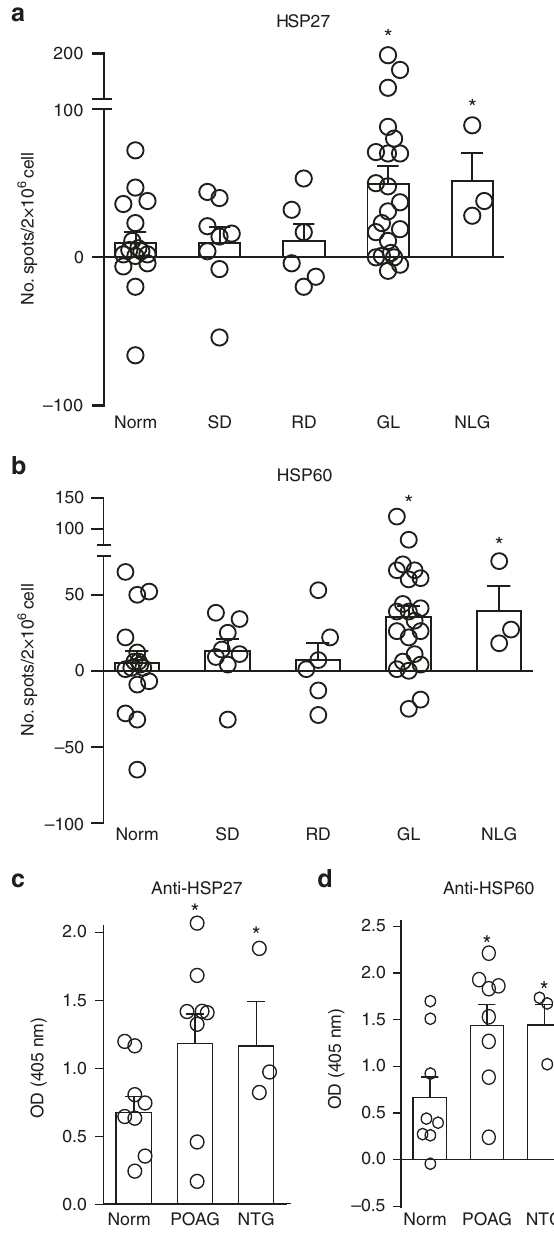
Fig. 6 T cells are involved in retinal neurodegeneration in human glaucoma patients. a , b Comparison of frequencies of HSP27- and HSP60-speci fi c T cells among healthy individuals and patients with POAG or other diseases. Peripheral blood mononuclear cells from patients with POAG ( n = 18), NTG ( n = 3), retinal detachment (RD; n = 6), skin injuries (SD; n = 8), and age- matched healthy controls (Norm; n = 16) were stimulated with HSP27 ( a ) or HSP60 ( b ). Two days later, the frequencies of IFN- γ -secreting cells were determined by ELISPOT. * P < 0.05 by ANOVA. c , d Comparison of serum levels of HSP27- and HSP60-speci fi c IgGs between healthy individuals and patients with POAG or NTG. Sera from POAG ( n = 18), NTG ( n = 3), and age-matched healthy individuals (Norm, n = 16) were assayed for HSP27- and HSP60-speci fi c IgG by ELISA. * P < 0.05 by